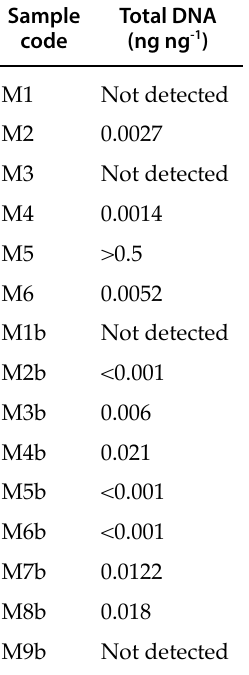
Table 3. The concentrations of DNA of fumonisin-produc- ing fungi maize (M) and wheat (W) grain samples from the Philippines and